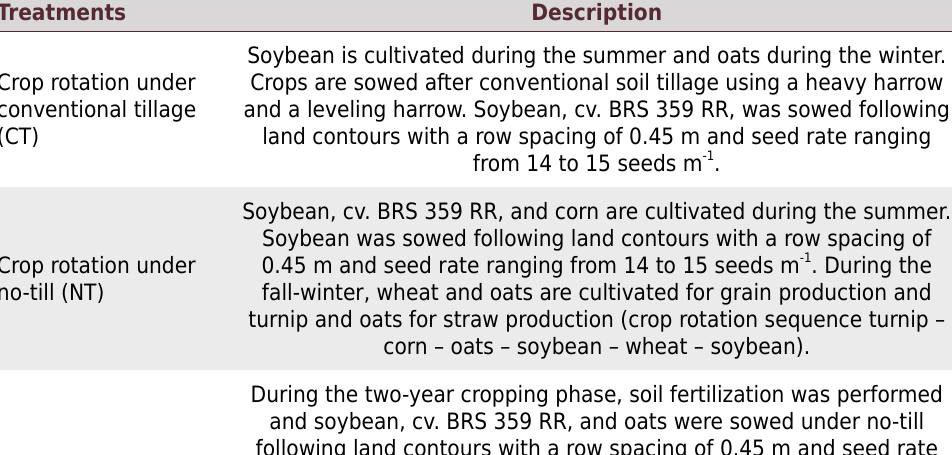
Table 1. Description of the six treatments under different agricultural management Treatments Description Crop rotation